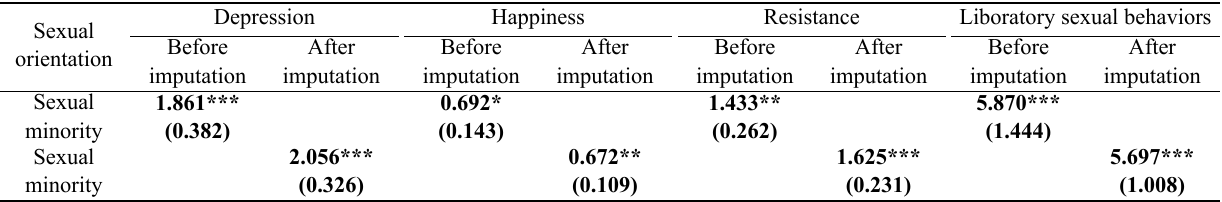
Table A1 Sexual orientation, psychological well-being, and gender attitude of Beijing college students (odds ratio). Sexual orientation